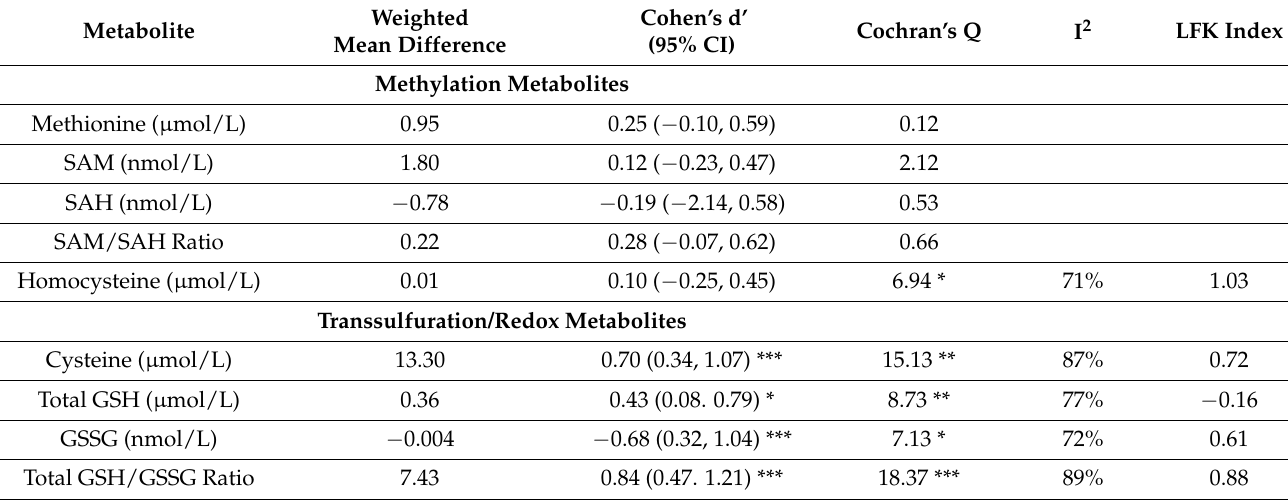
Table 3. Meta-analysis of biochemical changes with subcutaneously injected methylcobalamin in children with ASD. Oxi- dized glutathione (GSSG); S-adenosylhomocysteine (SAH); S-adenosylmethionine (SAM); methylation capacity (SAM/SAH); total GSH (tGSH); total glutathione redox ratio (tGSH/GSSG) * p < 0.05, ** p < 0.01, *** p <